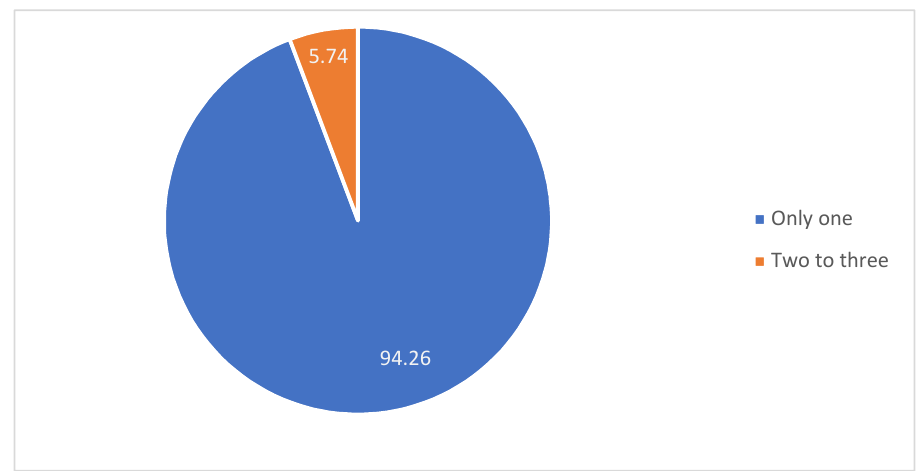
Table 2. Adoption of sustainable soil management practices by paddy farmers.